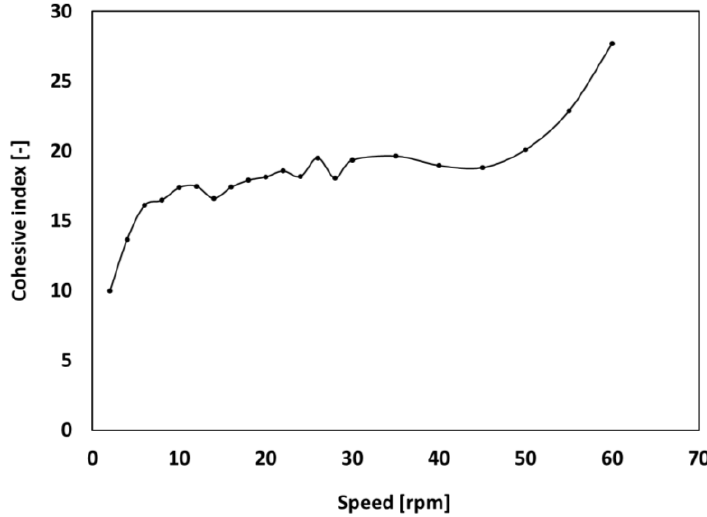
Figure 2. Cohesive index as a function of the rotation speed of the drum.